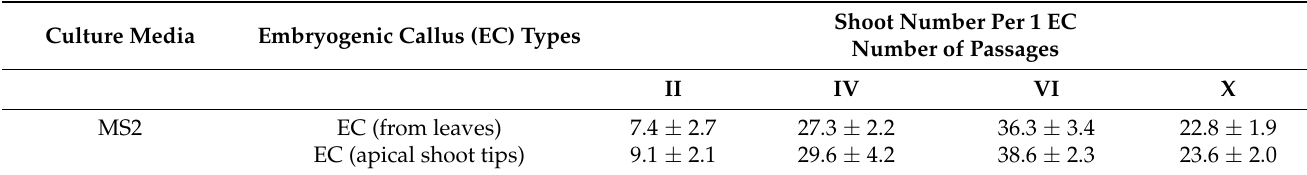
Table 3. Relationship between the number of passages and plant regeneration in embryogenic calli lines of Paulownia tomentosa